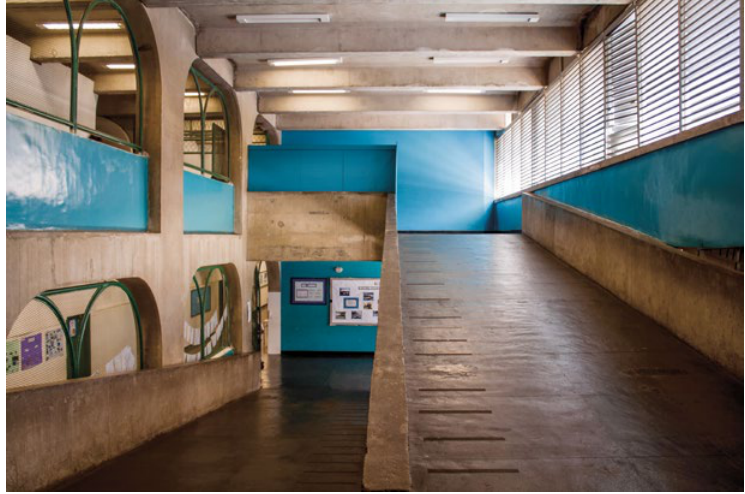
Figure 2 Internal ramps (bottom) linking the three floors of CIEP Doutor Antoine Magarinos Torres Filho, in Rio’s Borel district. Image © Aberrant